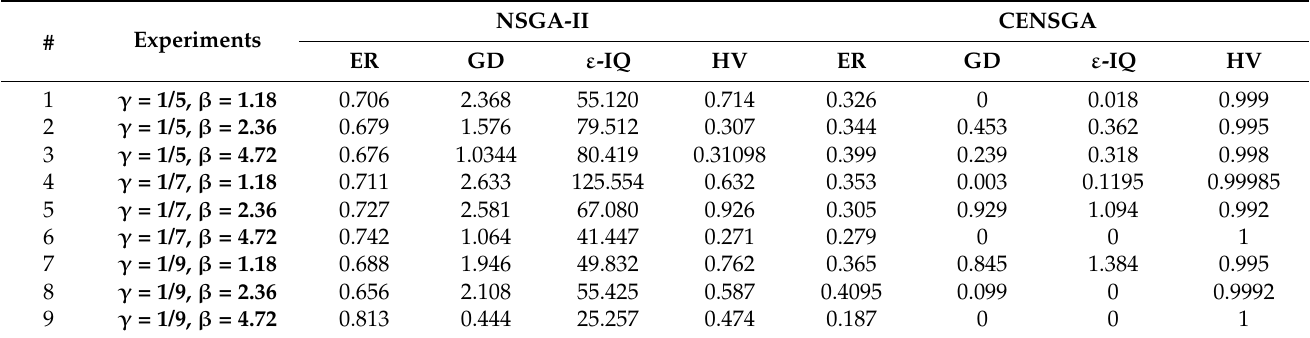
Table 5. Nine computational experiments and their associated QI